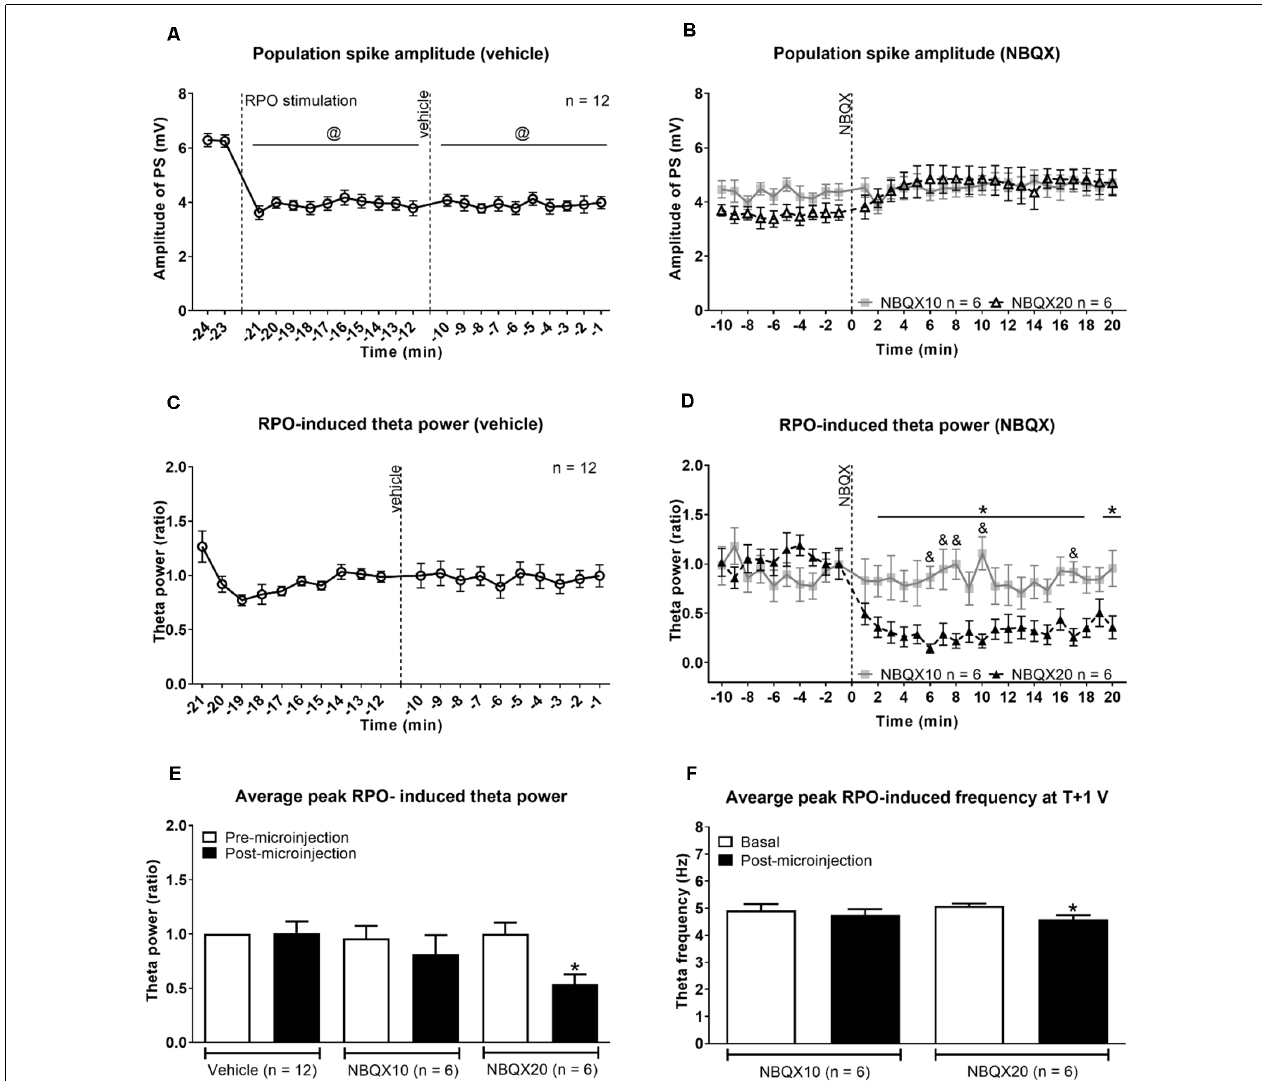
FIGURE 2 | Intraseptal microinjection of NBQX affects power and frequency of reticular stimulation-induced hippocampal theta wave activity in a dose-dependent fashion. (A,B) Time course of effect of intraseptal microinjection of vehicle and NBQX on the reticular stimulation-induced suppression of the CA1 population spike (PS) and (C,D) the power of the concomitant theta wave activity. The RPO was stimulated at an intensity that evokes 4–5 Hz theta wave activity (labeled as ‘T’ V). The stimulation was initiated at the time point shown in (A) and was subsequently maintained throughout the recording except for intermittent periods when T + 1 V stimulation was applied. The plot in (A) corresponds to (a) 2 min before the onset of RPO stimulation ( − 24 min and − 23 min), (b) 10 min following the onset of RPO stimulation, and before microinjection of vehicle ( − 22 min to − 12 min), and (c) 10 min following vehicle microinjection ( − 11 min to − 1 min). NBQX (10 or 20 µ g/ µ l, 0.5 µ l) was microinjected 10 min after vehicle microinjection (A) . This corresponds to 0 min in the plot (B) . The time course in (B) reflects 10 min before and 20 min after NBQX microinjection. Panels (C,D) are built as in (A,B) except power is not illustrated for the period before RPO stimulation since theta wave activity was not observed in this period. Furthermore, theta wave activity was lost around ∼ 30 s to 1 min in four of six experiments following microinjection NBQX 20 µ g/ µ l. In absence of overt theta, the peak FFT power in the theta range was used for drawing the plots. The FFT parameters and PS were computed in 1 min block. Power was expressed as a ratio of the average power in the 10 min preceding microinjection of vehicle. (C) As the effect of vehicle on PS and theta parameters was similar in both NBQX experiments, the vehicle data were combined for the two groups ( n = 12). Note that the higher dose of NBQX attenuated theta power (D) but not the suppression of PS (B) . (E) Histogram of FFT theta peak power (ratio) before and after microinjection of vehicle and NBQX. The histograms represent the average of RPO-induced theta peak power in two contiguous minutes before microinjection and the average of peak RPO-induced theta peak power in two contiguous minutes in the 5 min period after microinjection. (F) Histograms showing FFT theta peak frequency before and after microinjection of NBQX at T + 1 V. Since NBQX 20 µ g/ µ l evoked a loss of theta on RPO stimulation at intensity ‘T’, higher stimulation intensity at T + 1 was applied at 20 min after NBQX treatment to evoke theta wave activity which was then used for analysis. The theta frequency observed at 20 min post-NBQX was compared with the corresponding theta frequency evoked at T + 1 stimulation applied before the onset of time course investigations (Basal). Data are mean ± S.E.M. Significant difference ( p < 0.05): (A) @vs. corresponding PS amplitude at − 24, − 23 min, one-way repeated measures (RM) ANOVA followed by Newman-Keuls post hoc test. (D) Time course: *NBQX20 vs. corresponding − 2, − 1 min, and & NBQX20 vs. NBQX10, two-way RM ANOVA followed by Bonferroni post hoc test. (E,F) Histograms: *vs. pre-NBQX20 or Basal, two-tailed paired t